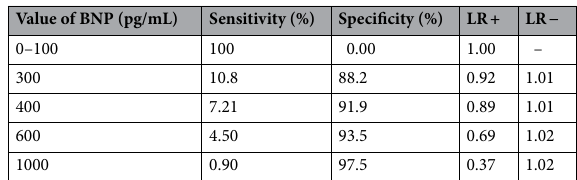
Table 6. Sensitivity and specificity for BNP to predict 90-day